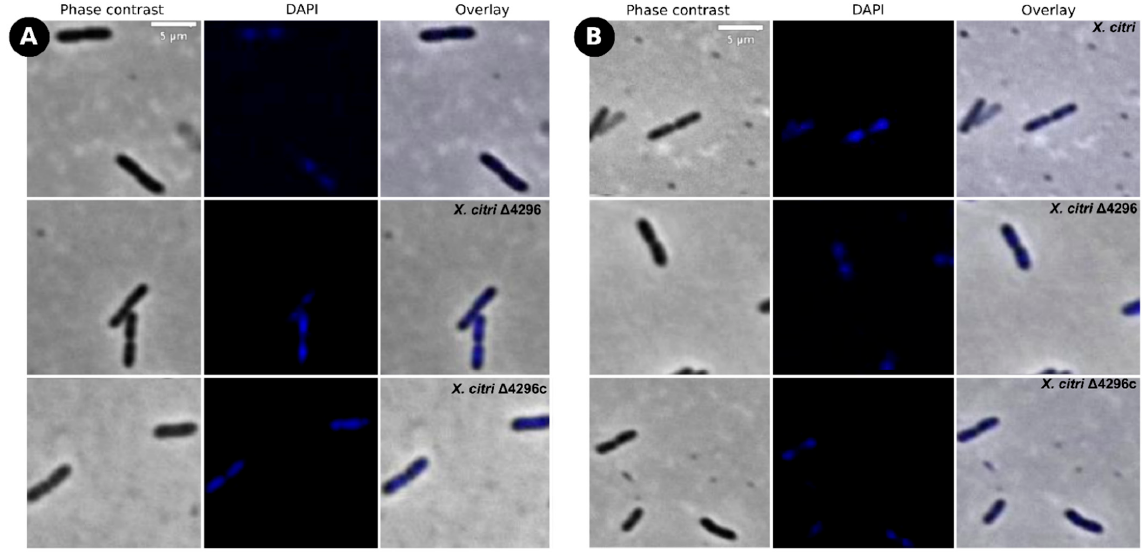
Figure 6. Short filaments, chain phenotype, and nucleoid organization show full reversion in glutamate’s presence as carbon source ( A ) Morphological analysis of X. citri , Δ 4296, and Δ 4296c strains on NB supplemented with glutamic acid 0.1% ( w / v ). ( B ) NB supplemented with glutamic acid 0.1% ( w / v ) and ampicillin 20 µg/mL. The figure shows the phase contrast, DAPI, and overlay of the two filters for X. citri, Δ 4296, and Δ 4296c (magnification of 100×)—Scale = 5 µm.